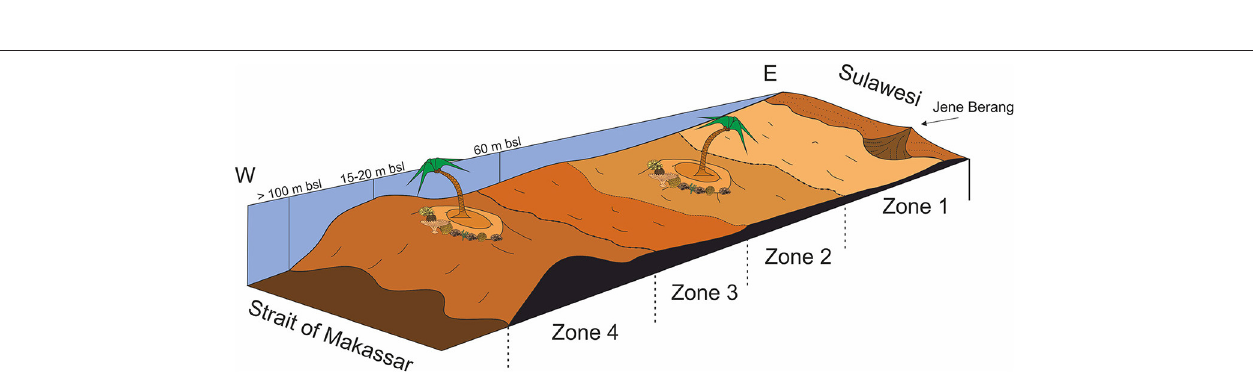
FIGURE 9 | Statistical comparison of the main surface sediment components from the four study islands P. Panamgangang, P. Tambakulu, and P. Suranti and P. Panambungan. Dots in red indicate cluster 1, while dots in black indicate cluster 2. Based on previous statistical analysis (k-means). On the right side, corresponding correlation coefficients is shown, with the highest correlation between coral and coralline algae fragments followed by corals to bivalves.